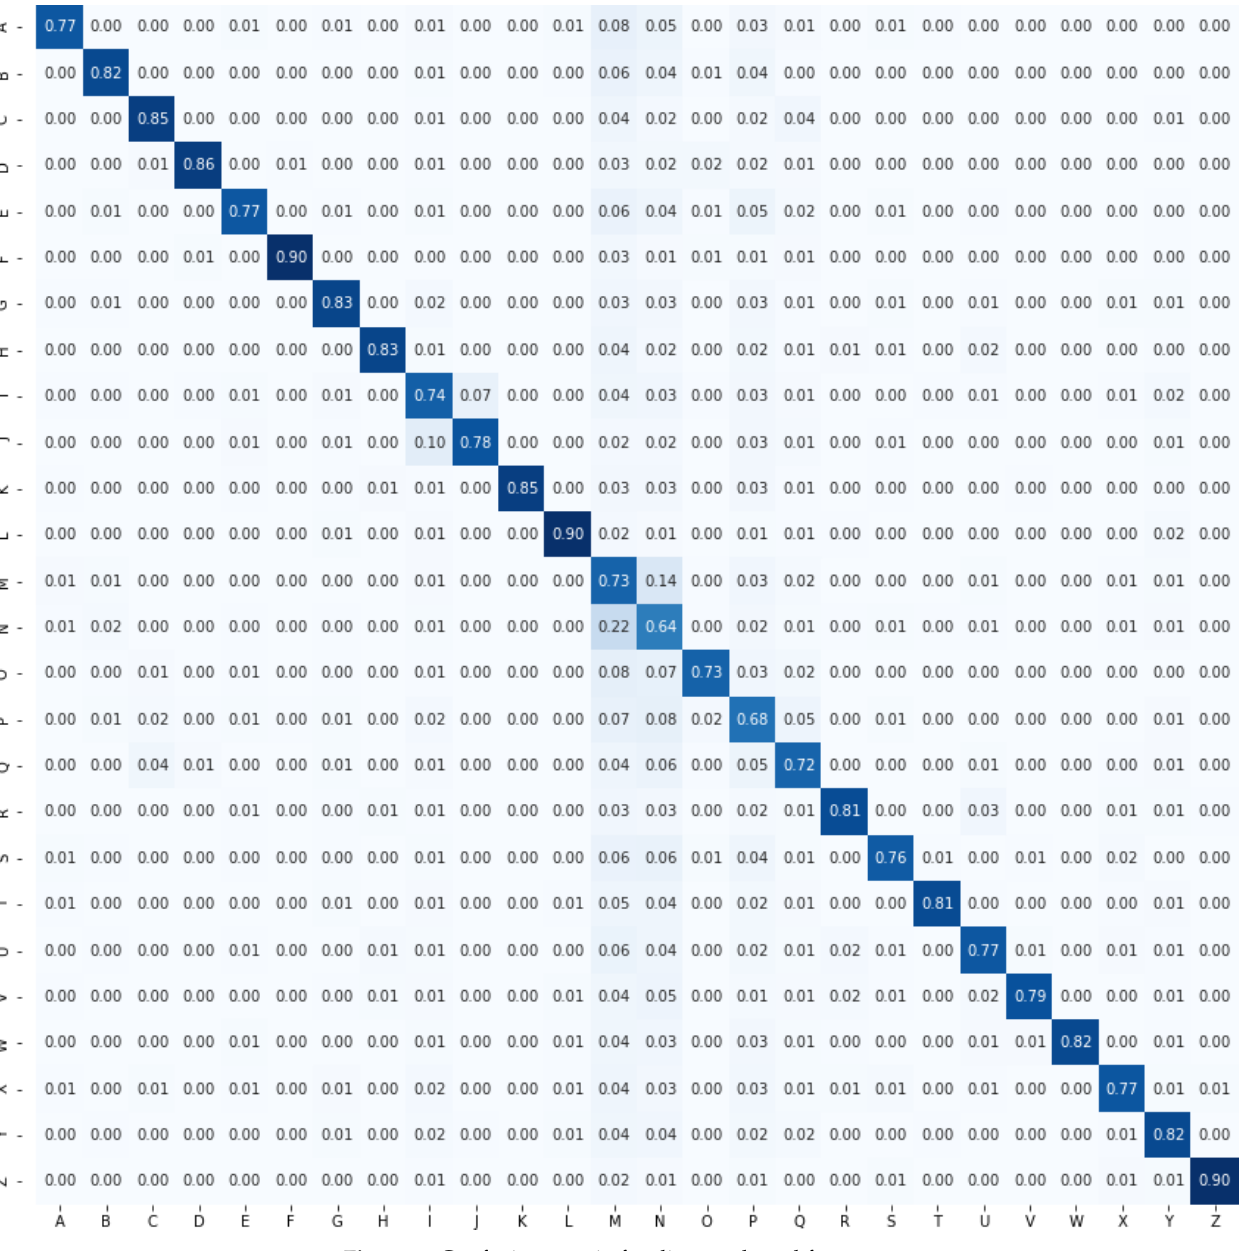
Figure 7. Confusion matrix for distance-based